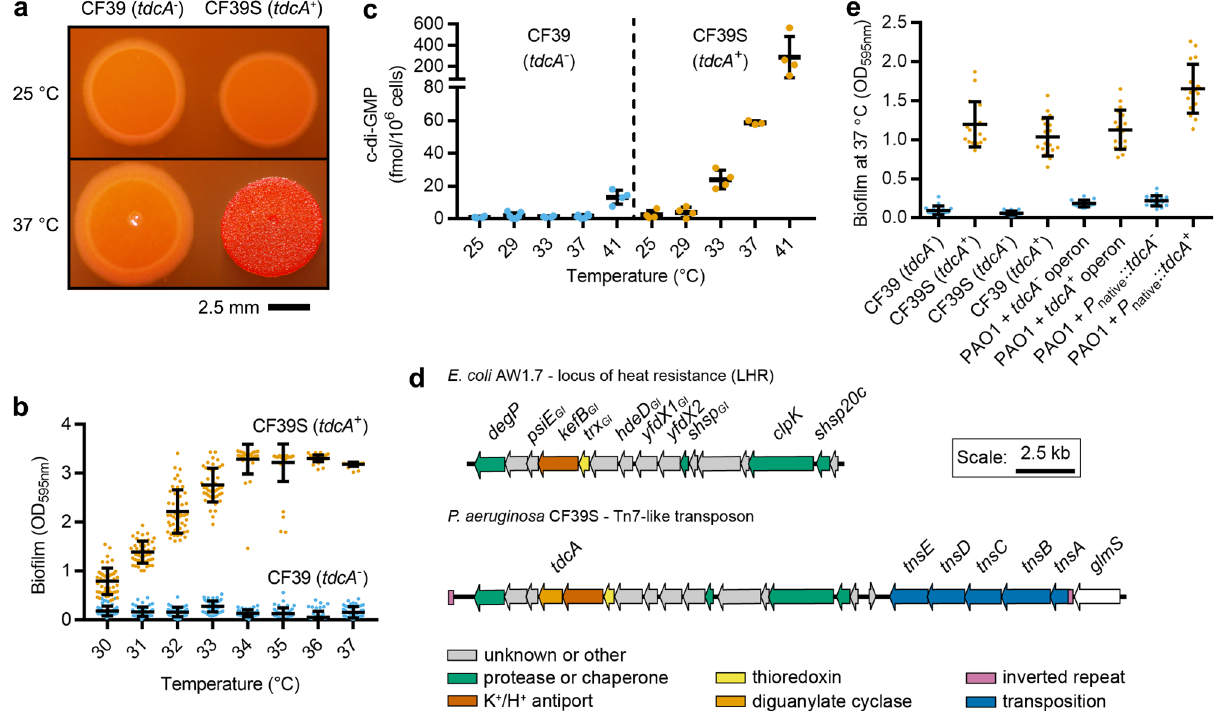
Fig. 1 Genomics and genetic linkage analysis identify a gene for the thermosensory diguanylate cyclase ( tdcA ) in P. aeruginosa CF39S. a P. aeruginosa CF39S displays temperature-dependent rugose colony morphology on agar. b P. aeruginosa CF39S exhibits temperature-dependent bio fi lm formation in microplates. Datum points represent 16 technical replicates from each of three biological replicates, and lines and bars represent means and standard deviations, respectively. c Liquid chromatography tandem mass spectrometry (LC – MS/MS) measurements of cellular nucleotide pools revealed that P. aeruginosa CF39S displays temperature-dependent increases in cyclic diguanylate (c-di-GMP). Each datum point represents an independent biological replicate, and lines and bars represent means and standard deviations, respectively, for 3 – 5 independent biological replicates each. d Schematic illustrating the Tn7-like transposon in the P. aeruginosa CF39S chromosome encoding tdcA and its synteny to the E. coli AW1.7 locus of heat resistance (LHR). Annotations for the E. coli AW1.7 genome were taken from Mercer and colleagues 44 . Open reading frames are color coded by putative functions as illustrated in the legend: gray arrows denote genes of unknown function or functions other than those illustrated here; bluish green arrows denote genes for putative proteases or chaperones; yellow arrows denote genes for thioredoxins; orange arrow denotes a diguanylate cyclase; blue arrows denote genes encoding functions for transposition; and reddish purple segments denote inverted repeats. e Acquisition of tdcA confers thermal control of P. aeruginosa bio fi lm formation in microplates. Datum points represent six technical replicates from each of three biological replicates, and lines and bars represent means and standard deviations, respectively. In b , c , and e , tdcA − and tdcA + strains are represented by sky blue and orange dots, respectively. Strains denoted tdcA − have the tdcA 162 Δ G allele. OD 595nm denotes the optical density measured at a wavelength of 595